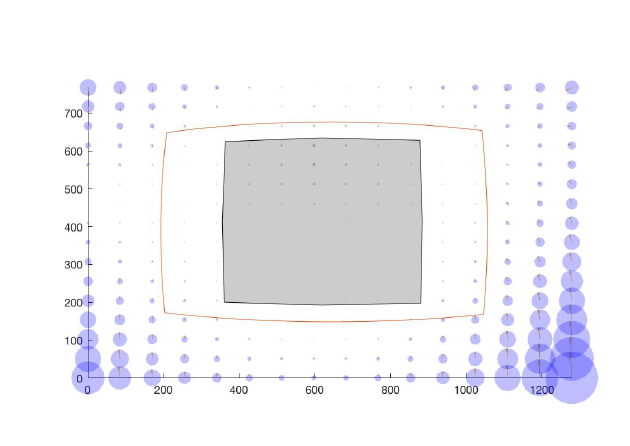
Figure 11 . Calibration grid (small circles) and working area (red rectangle) marked in the calibration plane and borders of the scene image when it is back-projected onto the calibra- tion plane with (dashed line) and without (dotted line) lens distortion. This figure was drawn according to the settings described in Table 5.